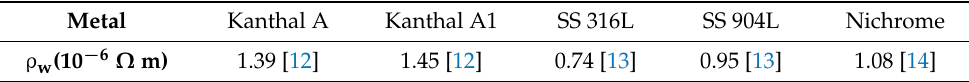
Table 3. Electric resistivity of the wire metals reported in Table 2.